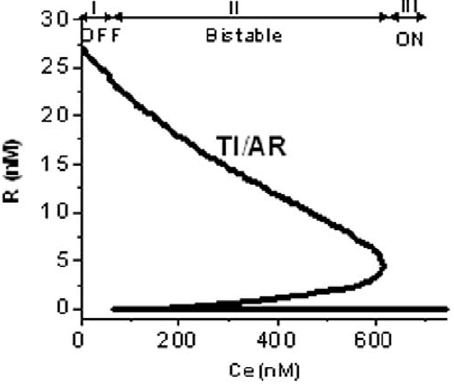
Figure 4. Bistable steady state response of ScbA/ScbR system to extracellular SCB1 in presence of convergent transcription. Steady state response of ScbR to constant extracellular SCB1 concentration. Parameters used for simulation are listed as nominal case in Table 3. Bistability is predicted in the case of convergent transcription. Region I and II indicate the monostable region of bistable curve corresponding to OFF and ON states respectively. Region III indicates the bistable region. The state of the system depends on its history. System originating from OFF state continues to be OFF in the bistable region, while system originating from ON state, stays ON in the bistable region. The system requires a higher concentration of SCB1 to turn ON than to turn back OFF.